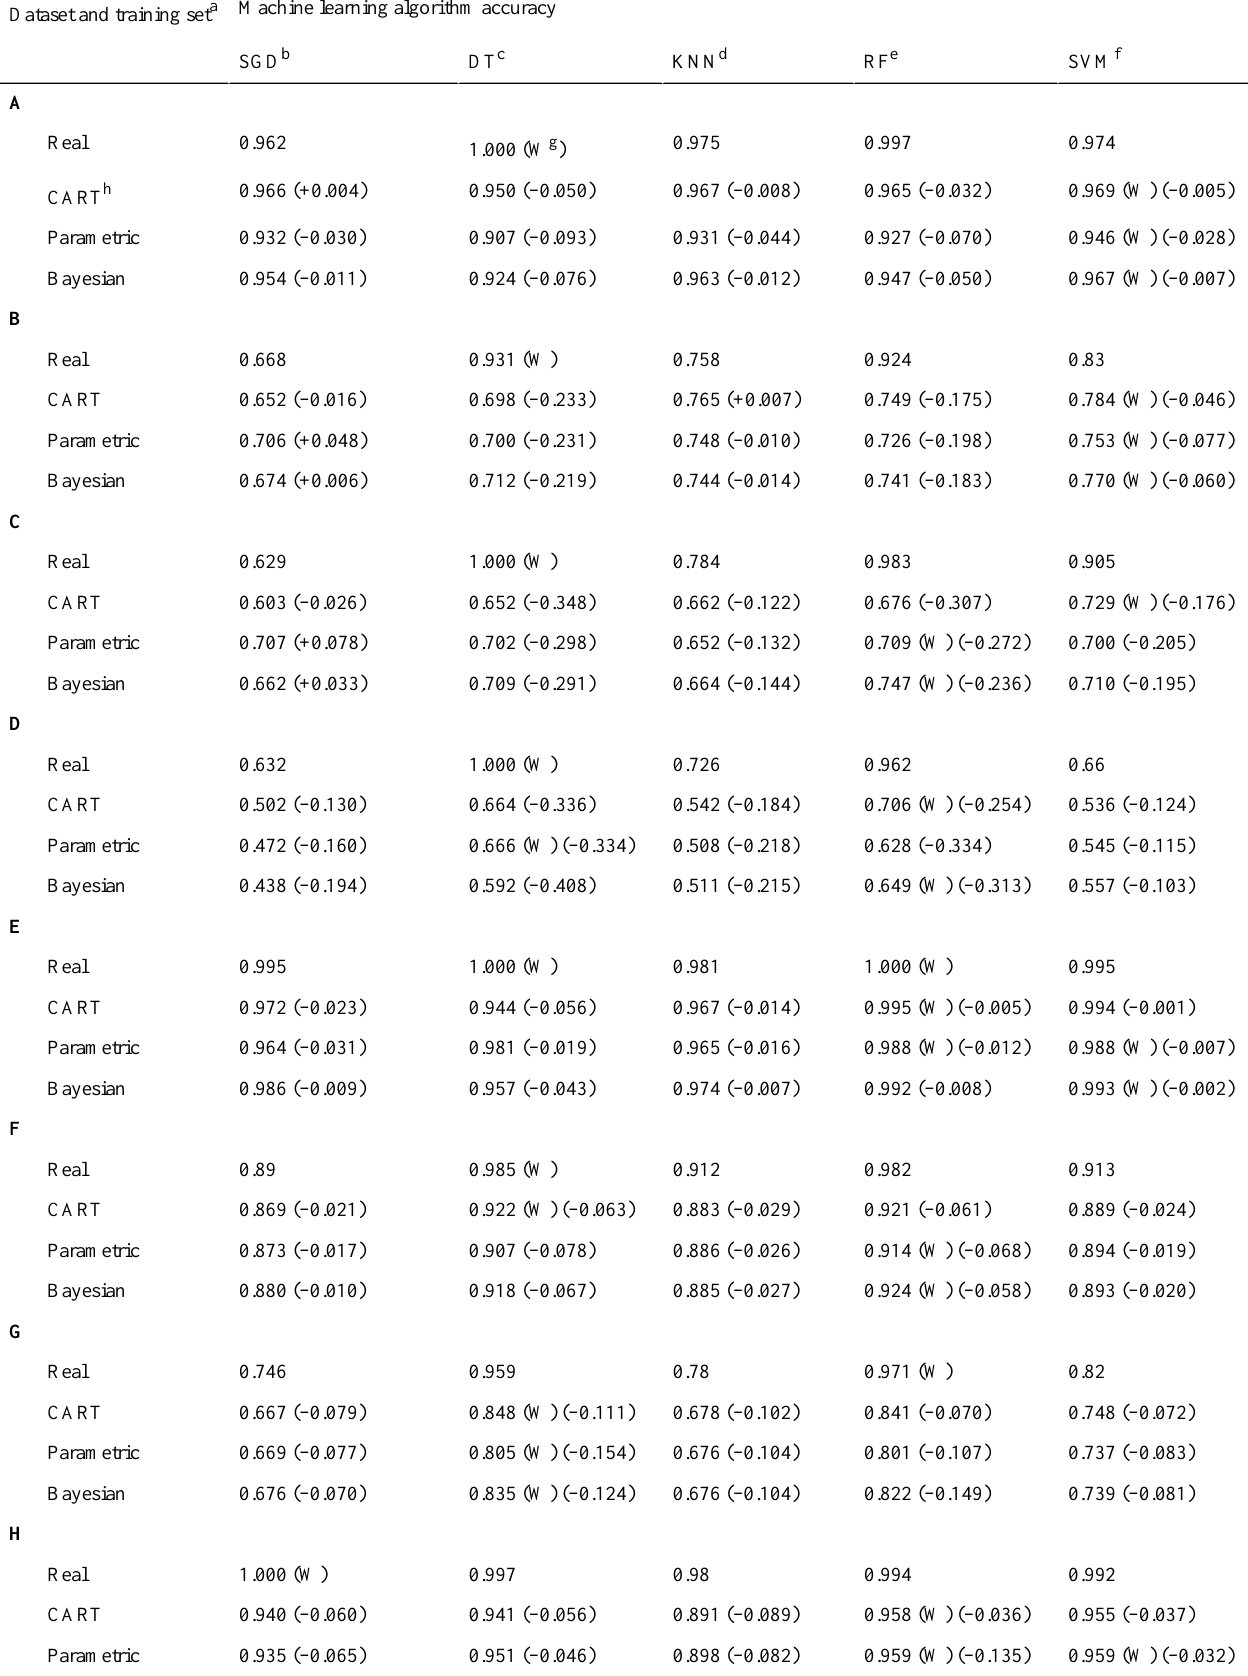
Table 2. Comparison of accuracy scores of five supervised machine learning models trained on real data and synthetic data across 19 datasets. Increase or decrease in accuracy compared with the model trained on real data shown in